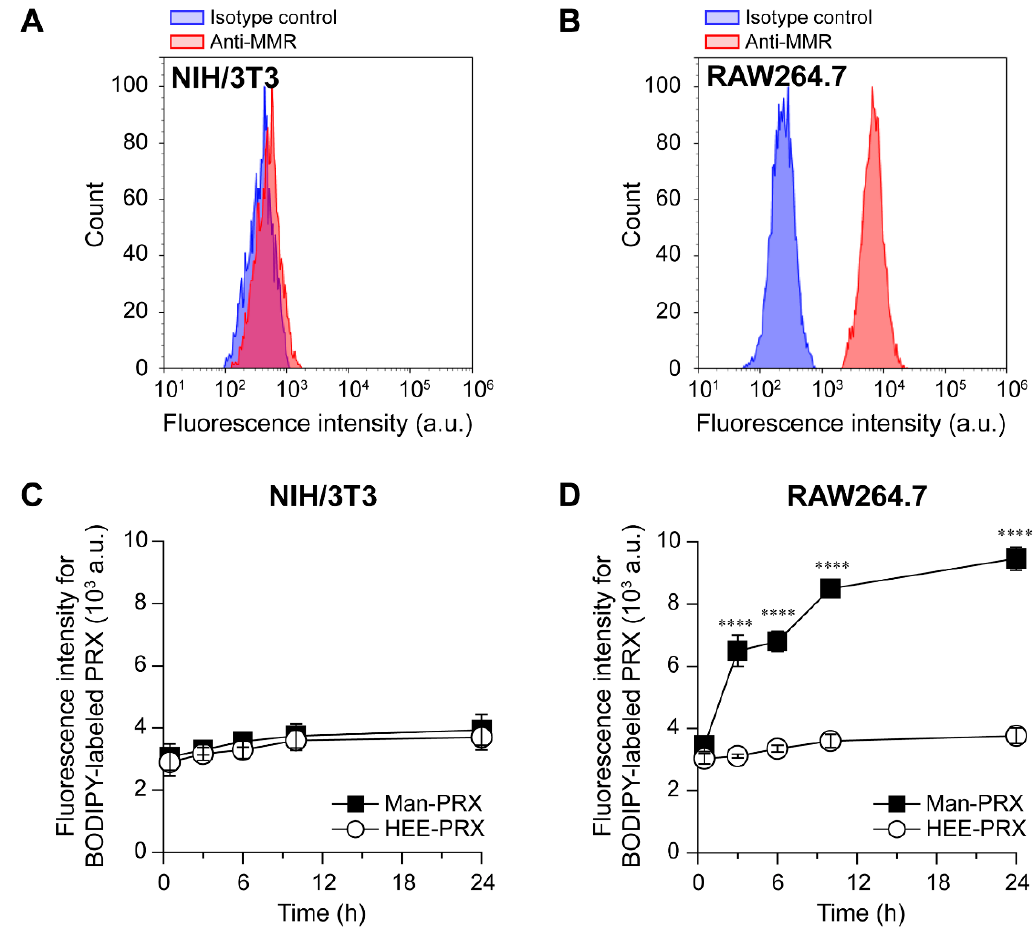
Figure 5. Fluorescence intensities of ( A ) NIH/3T3 and ( B ) RAW264.7 cells treated with the APC-labeled IgG2a, κ isotype control and APC-anti-MMR antibody. The time course of fluorescence intensity of ( C ) NIH/3T3 and ( D ) RAW264.7 cells treated with BODIPY-HEE-PRX (10 µ M, open circles) and BODIPY-Man-PRX (10 µ M, closed squares). Data are expressed as mean ± standard deviation (n = 3, **** p < 0.001).